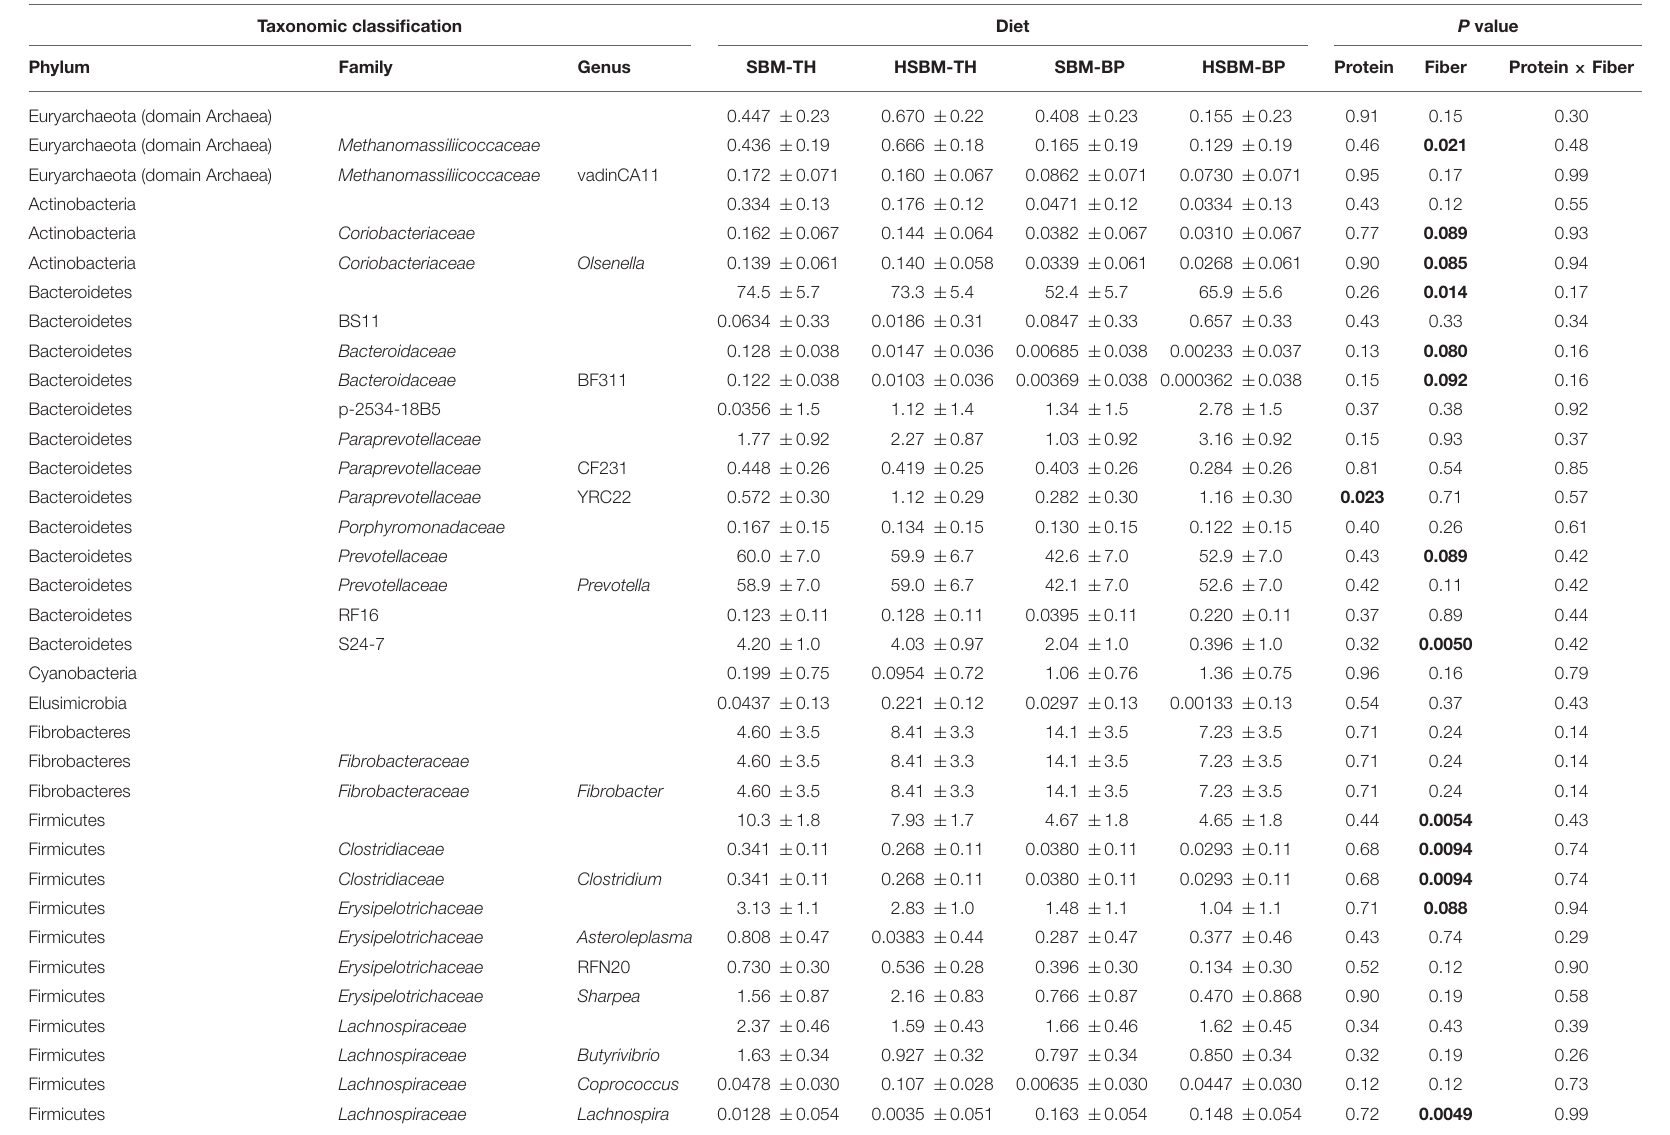
TABLE 3 | LS means ± SE for percent relative abundances of bacterial taxa identified in the rumen solid fraction as differentiated by diet along with P values for the effects of protein source, fiber source, and the interaction of protein and fiber source a,b